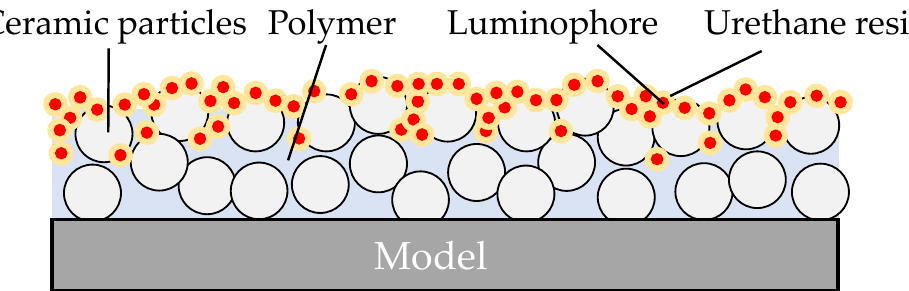
Figure 1. PC-PSP with added Urethane resin